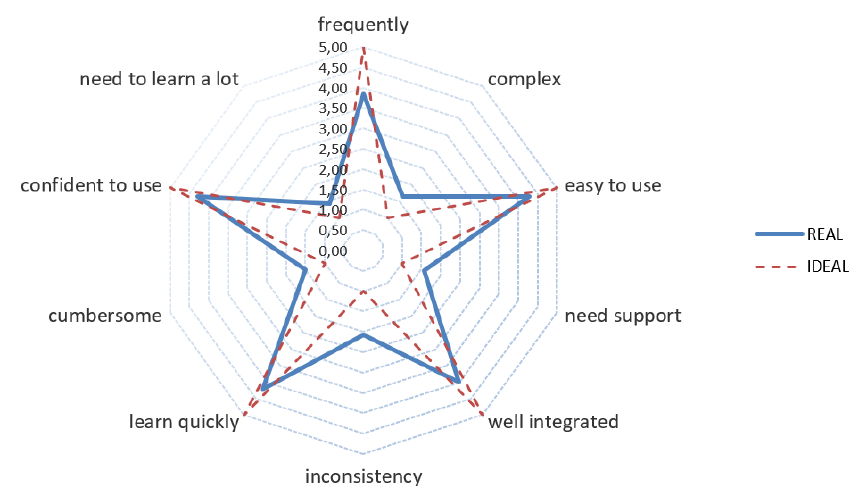
Figure 12. Evaluation of the five-pointed